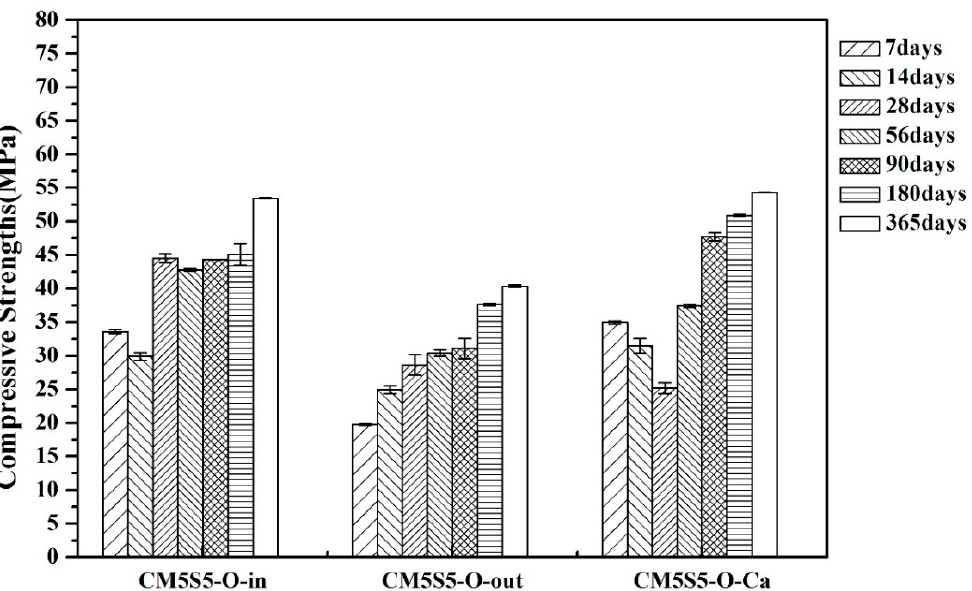
Figure 4. Effect of the curing environment on the compressive strength of marble-based geopolymer concrete (original designed ratio).